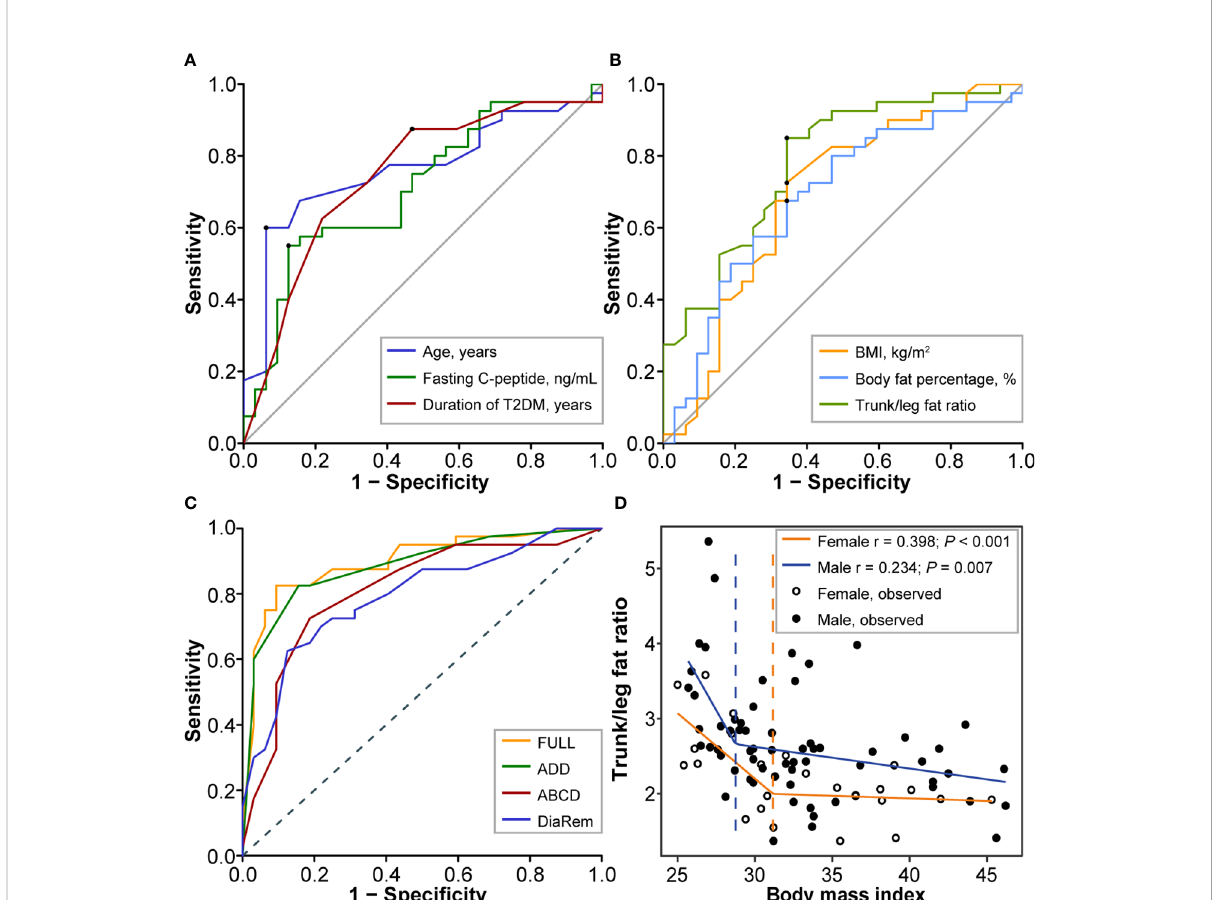
FIGURE 1 Screening and assessment of predictors. (A) The ROC curves for age (cutoff 39.0 years, sensitivity 0.600, speci fi city 0.938, the Youden index 0.538, AUC 0.762), fasting C-peptide (cutoff 3.1 ng/mL, sensitivity 0.550, speci fi city 0.875, the Youden index 0.425, AUC 0.711), and duration of T2DM (cutoff 6.5 years, sensitivity 0.875, speci fi city 0.0.531, the Youden index 0.406, AUC 0.744). (B) The ROC curves for BMI (cutoff 30.5 kg/m 2 , sensitivity 0.725, speci fi city 0.656, the Youden index 0.381, AUC 0.690), body fat percentage (cutoff 33.5%, sensitivity 0.675, speci fi city 0.656, the Youden index 0.331, AUC 0.688), and trunk/leg fat ratio (cutoff 2.63, sensitivity 0.850, speci fi city 0.656, the Youden index 0.516, AUC 0.784). (C) The ROC curves for the full model (AUC 0.896, 95%CI 0.821-0.972), the ADD tool (AUC 0.883, 95%CI 0.806-0.961), the ABCD score (AUC 0.809, 95%CI 0.705-0.913), and the DiaRem score (AUC 0.792, 95%CI 0.688-0.896) in predicting T2DM remission after bariatric surgery. (D) The nonlinear relationship between trunk/leg fat ratio and BMI. The break points showing a sharp change in slope are indicated by a dashed line with the corresponding color. Break points of BMI were respectively 28.75 kg/m 2 (males) and 31.17 kg/m 2 (females) for trunk/leg fat ratio. ROC, Receiver operating characteristic; AUC, Area under the curve; BMI, Body mass index; CI, Con fi dence interval; T2DM, Type 2 diabetes